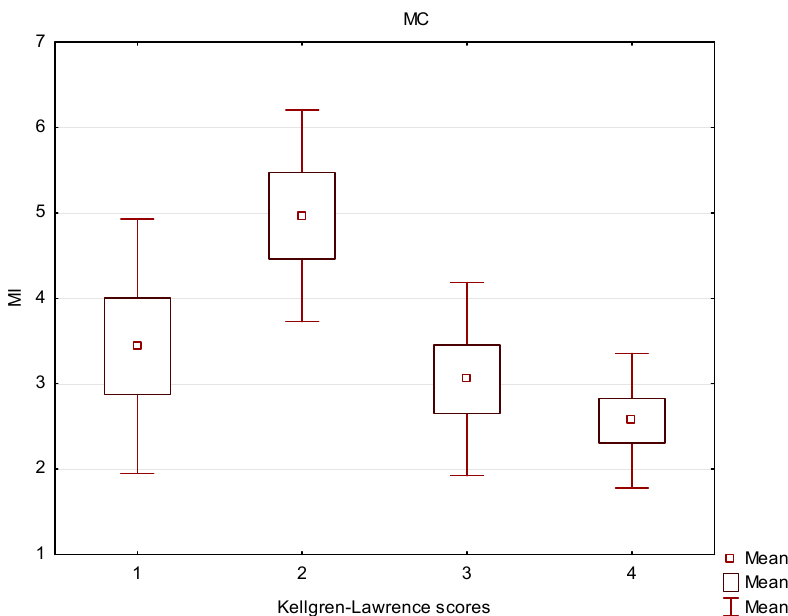
Figure 13. Box and whisker plot of the mineralization index (MI) in patients with different Kellgren– Lawrence scores in the medial condyle (MC).